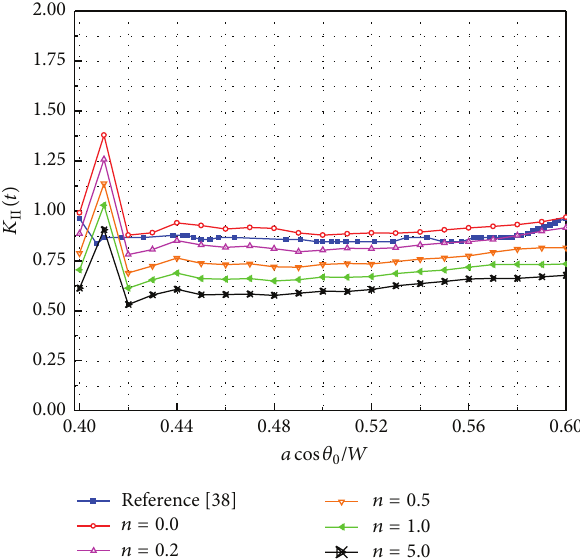
Figure 16: Normalized stress intensity factors 𝐾 II (𝑡) for propagating crack ( 𝐶 = 0.2